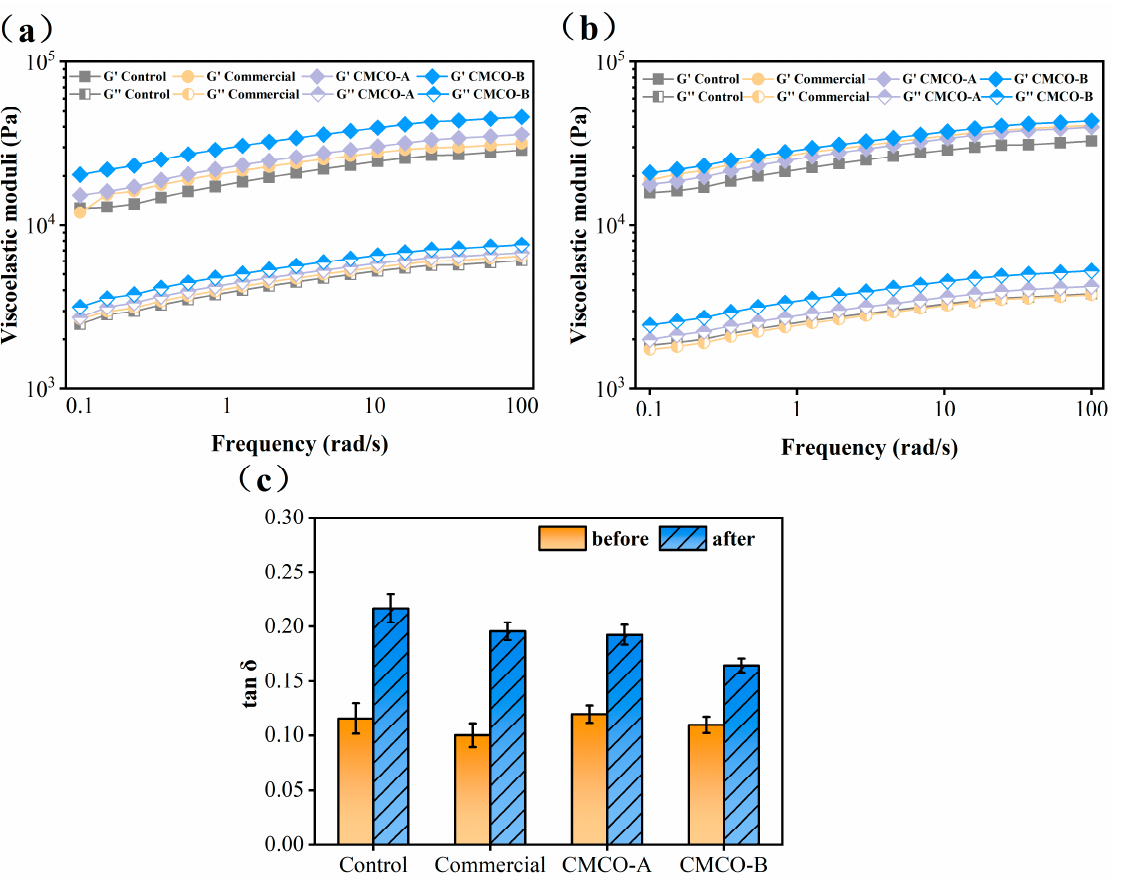
Figure 5. Dynamic rheological properties of the gels prepared from frozen surimi before ( a ) and after ( b ) frozen storage, and ( c ) tan δ of surimi gel within the linear viscoelastic region. Values with different uppercase letters indicate statistically significant difference among samples with different cryoprotectants at the same storage time ( p < 0.05). Values with different lowercase letters indicate significant difference among samples with the same cryoprotectants at different storage time ( p < 0.05).